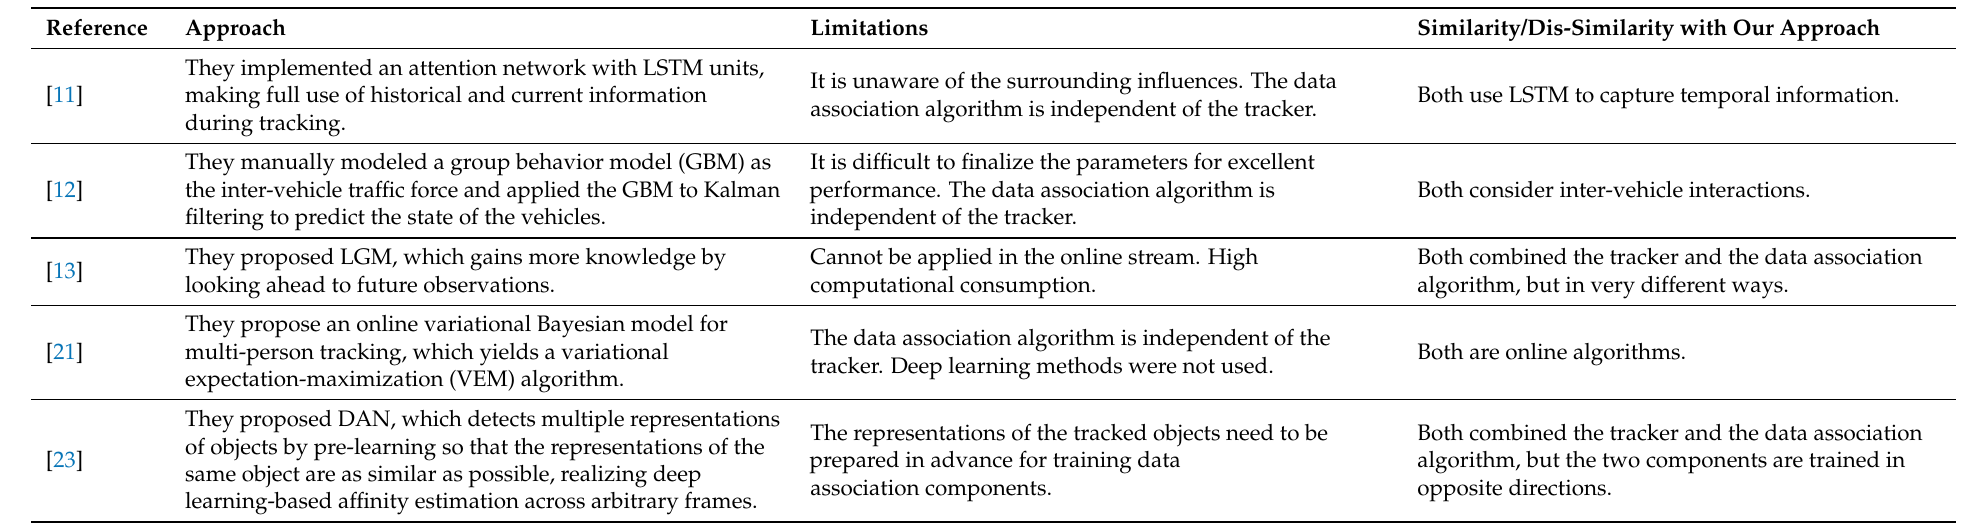
Table 1. Summary of selected related